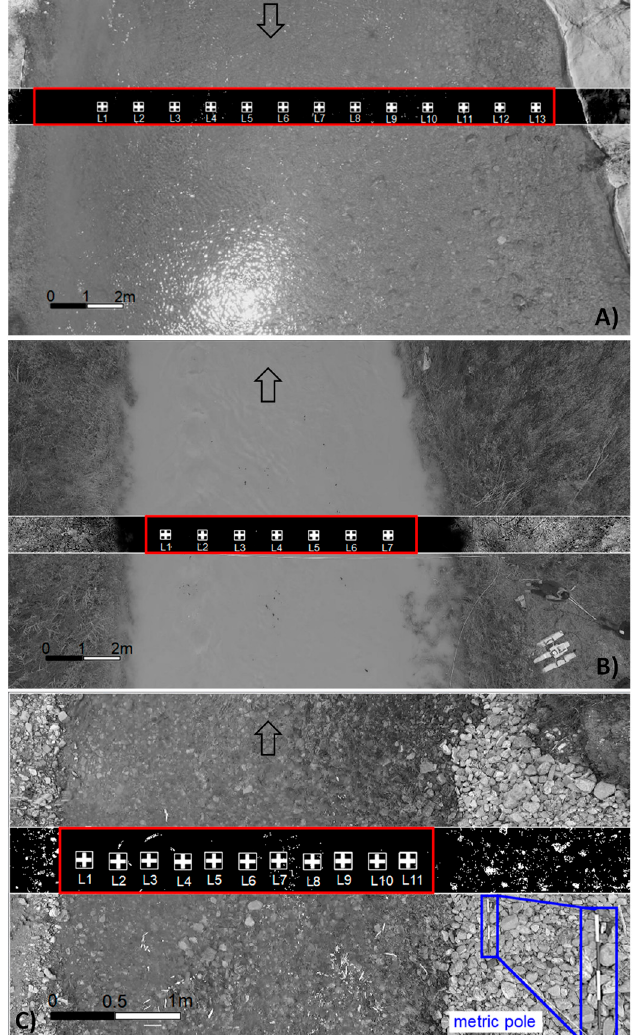
Figure 3. Frames acquired at ( A ) Noce, ( B ) Bradano, and ( C ) Basento Rivers. Dark zones represent frames after contrast stretching, enhancing the contrast between tracers and background. Regions of interest (ROIs) are shown in red squares and locations of reference velocity measurements as white crosses. The main flow direction is indicated by arrows. A zoom-in of the metric pole is shown in (C).